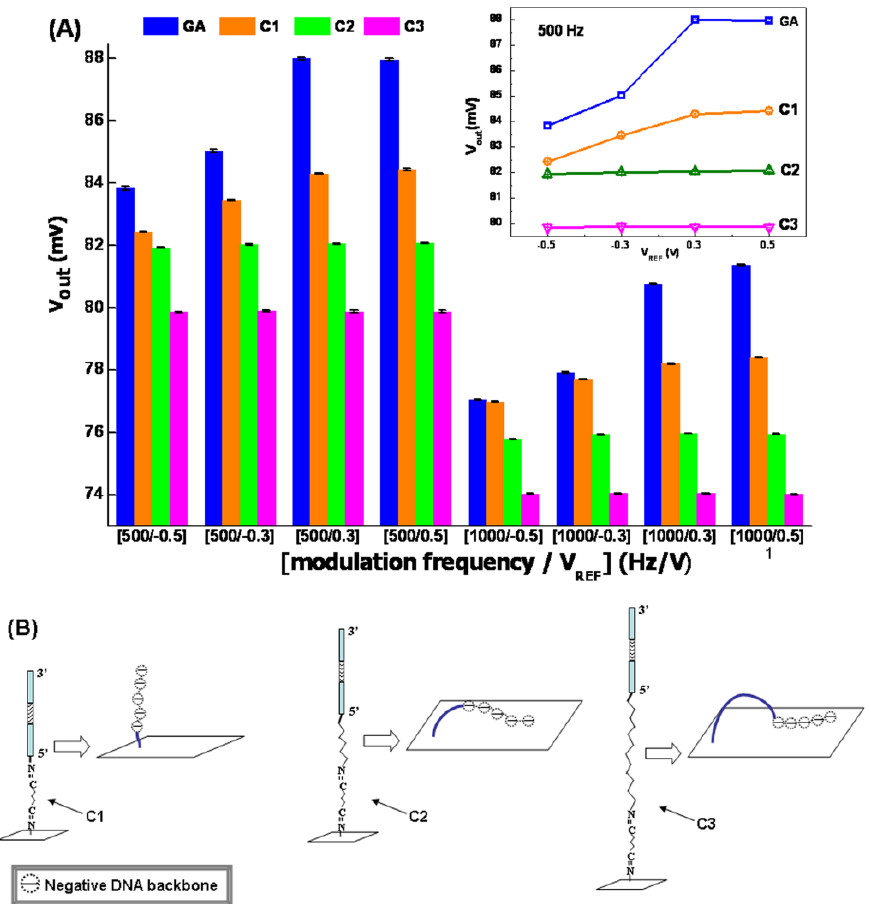
Figure 3. Influence of grafting ssDNA probes with different flexibility on LAPS and the schematic interpretation for the experimental results. ( A ) LAPS’ output voltages’ variation after binding with ssDNA probes at different working conditions which was denoted as [modulation frequency/ V REF ], while the electronic features of aptamer-modified LAPS at the selected modulation frequency were analyzed (given in the inset); and ( B ) the shapes of three probes C1, C2, and C3 on the LAPS surface. Third, it was deduced that the quantities of absorbed negative charges on C2 and C3 samples were so large that the selected V REF could not make LAPS work in the depleted state, so the curves of C2 and C3 were not in the linear region.